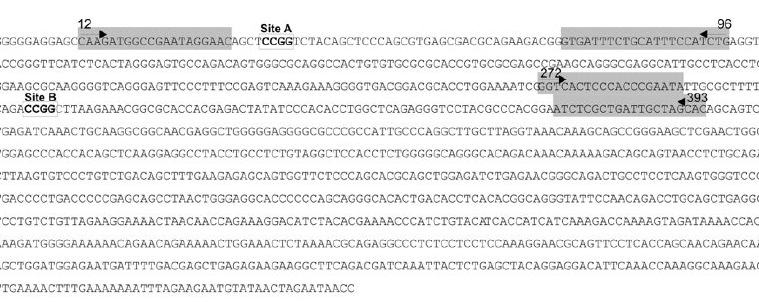
Figure 1. Longinterspersednuclearelement1(LINE-1)promotersequence. RecognitionsitesofMspI / HpaII isoschizomers are shown in bold; grey boxes and arrows indicate forward and reverse primers.